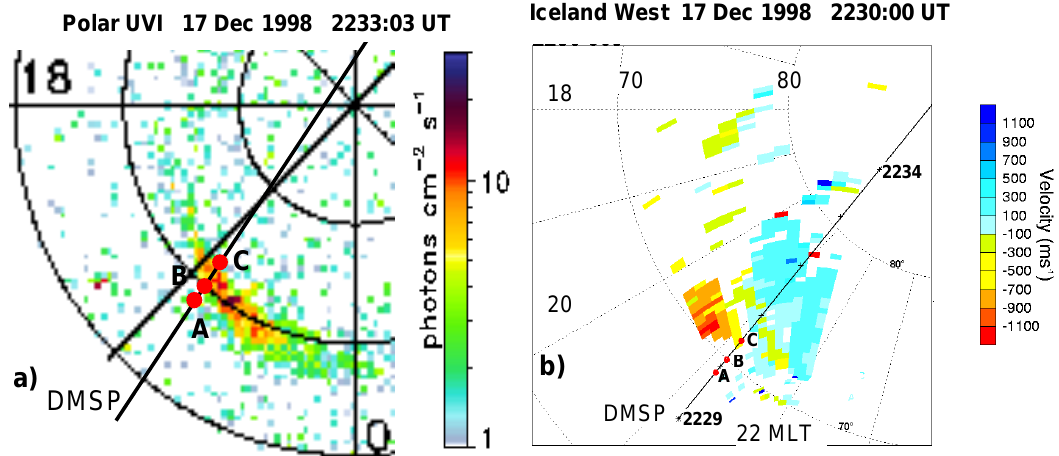
Fig. 6. Aurora and convection at the time of the DMSP pass. (a) POLAR UVI image. (b) Radial velocity maps from the Iceland-West radar. The red dots show the location of the particle boundaries A, B, C indicated on Fig.